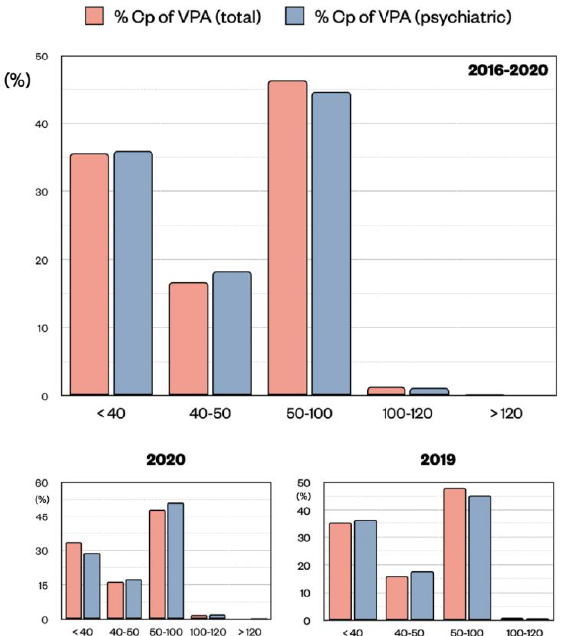
Figure 3. Distribution of VPA Cp (μg /mL) expressed as percentage of the total population (pink) or of the psychiatric unit only (blue) divided by ranges (<40, 40 – 50, 50 – 100, 100 – 120, >120). Data are shown for all five years from 2016 to 2020, and for the single years 2020 and 2019, respectively. No significant difference was observed in the distribution of Cp samples in the two populations by means of z